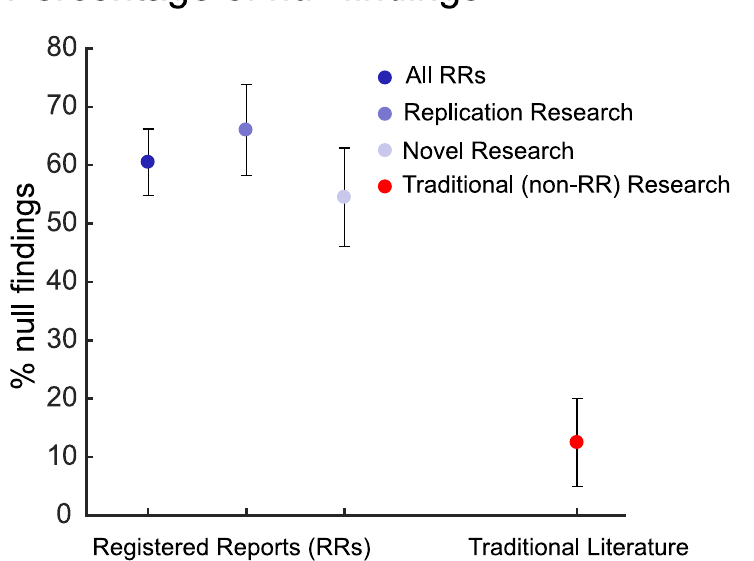
Fig 1. Percentages of null findings among RRs and traditional (non-RR) literature [46,47],with their respective 95% confidence intervals. In total, we extracted n = 153 hypotheses from RRs that were declared as replication attempts and n = 143 hypotheses that were declared as original research. The bounds of the confidence intervals shown for traditional literature were based on estimates (5% and 20%, respectively) of null findings that have been previously reported for traditional literature [46,47]. Data is available on the Open Science Framework (https://osf.io/wy2ek/) and in S1 Data. RR, registered report.